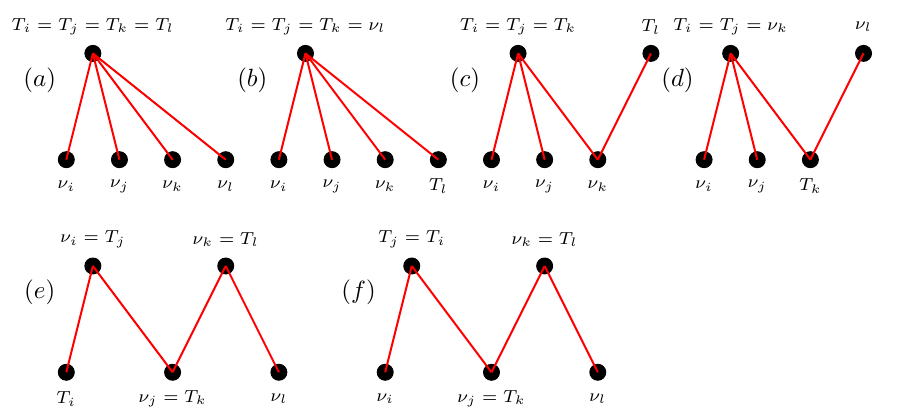
Figure 7.1: Different components of size of five. (a) T i = T j = T k = T l , (b) T i = T j = T k = ν l , (c) T i = T j = T k , ν k = T l , (d) T i = T j = ν k and T k = ν l , (e) ν i = T j , ν j = T k , ν k = T l , and (f) T i = T j , ν j = T k , ν k = T l